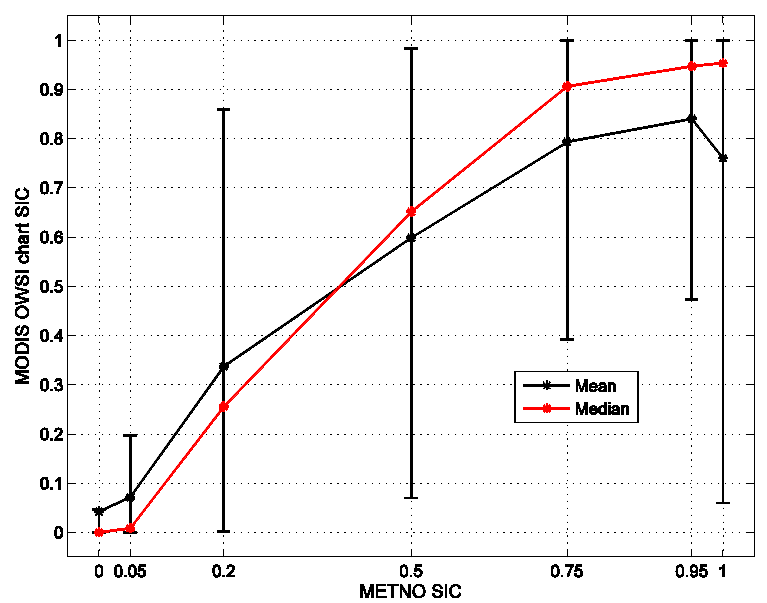
Figure 18. Comparison between the sea ice concentration estimates from the METNO ice chart and the MODIS open water–sea ice (OWSI) chart. The comparison period is March–June 2016. Vertical bars show 10% and 90% percentiles of the MODIS SIC estimates for each METNO chart SIC value. The METNO SIC of 1.0 is only for landfast ice, see text for explanation for large MODIS SIC variation.